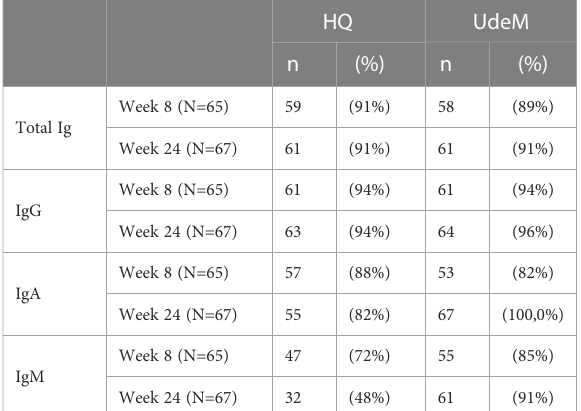
TABLE 3 Seroconversion in SARS-COV-2-positive individuals determined on weeks 8 and 24 at each test site, according to total Ig, IgG, IgA or IgM anti-spike (Wuhan-Hu-1) response.